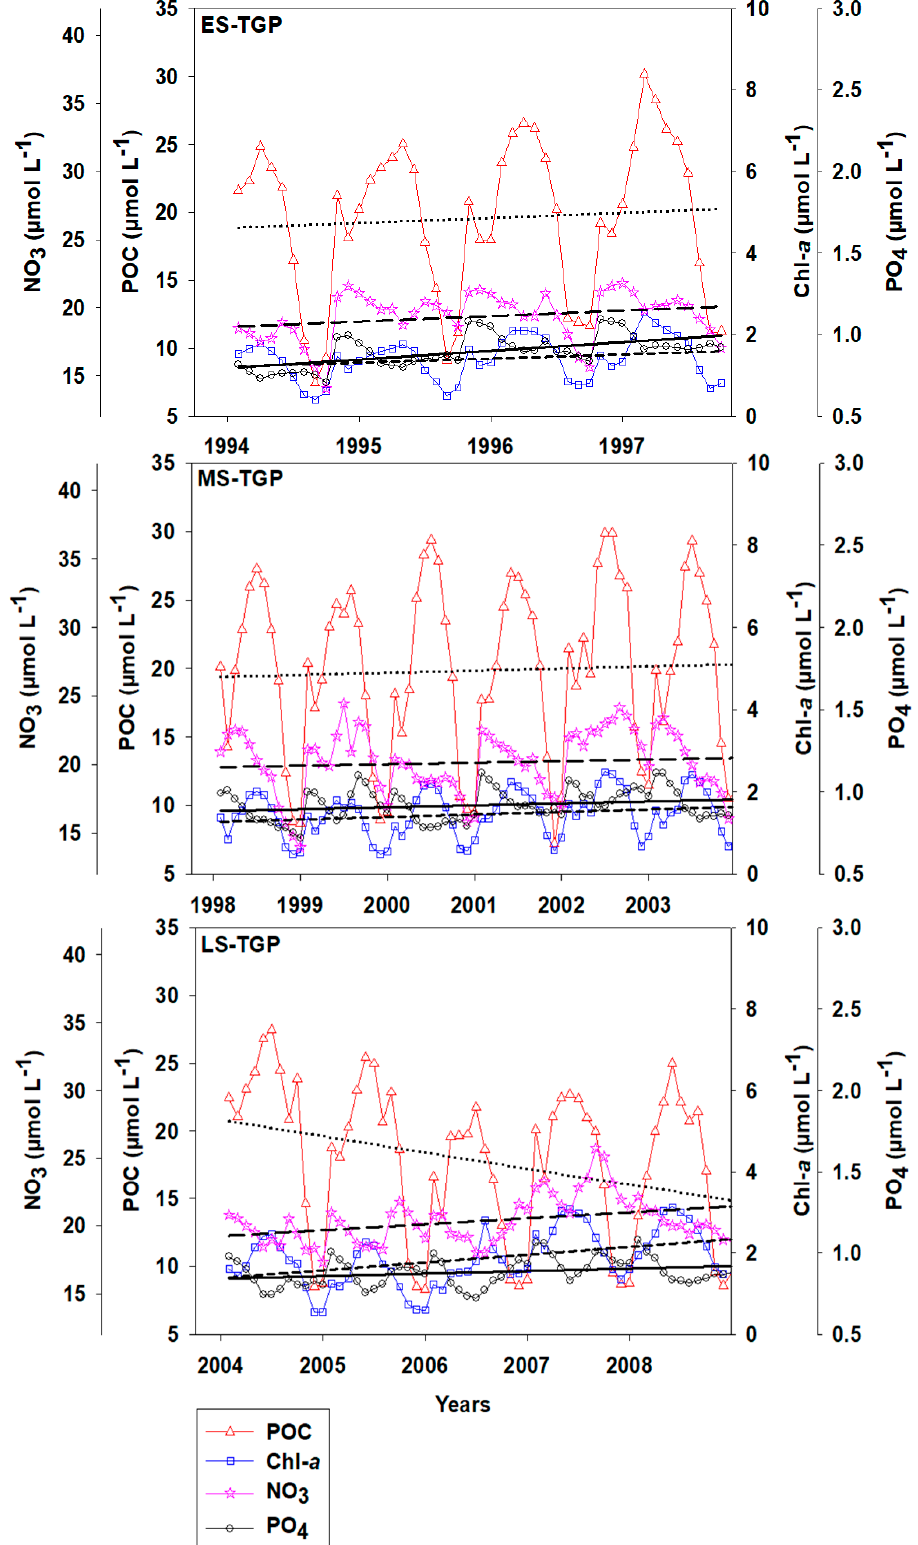
Figure 7. Long-time series variation of the modeled POC (red triangles) / Chl- a (blue squares) / NO 3 (pink stars) / PO 4 (black circles) during the three TGP periods. The dotted, long dashed, short dashed, and solid lines represent the POC, Chl- a , NO 3 , and PO 4 trendlines, respectively.